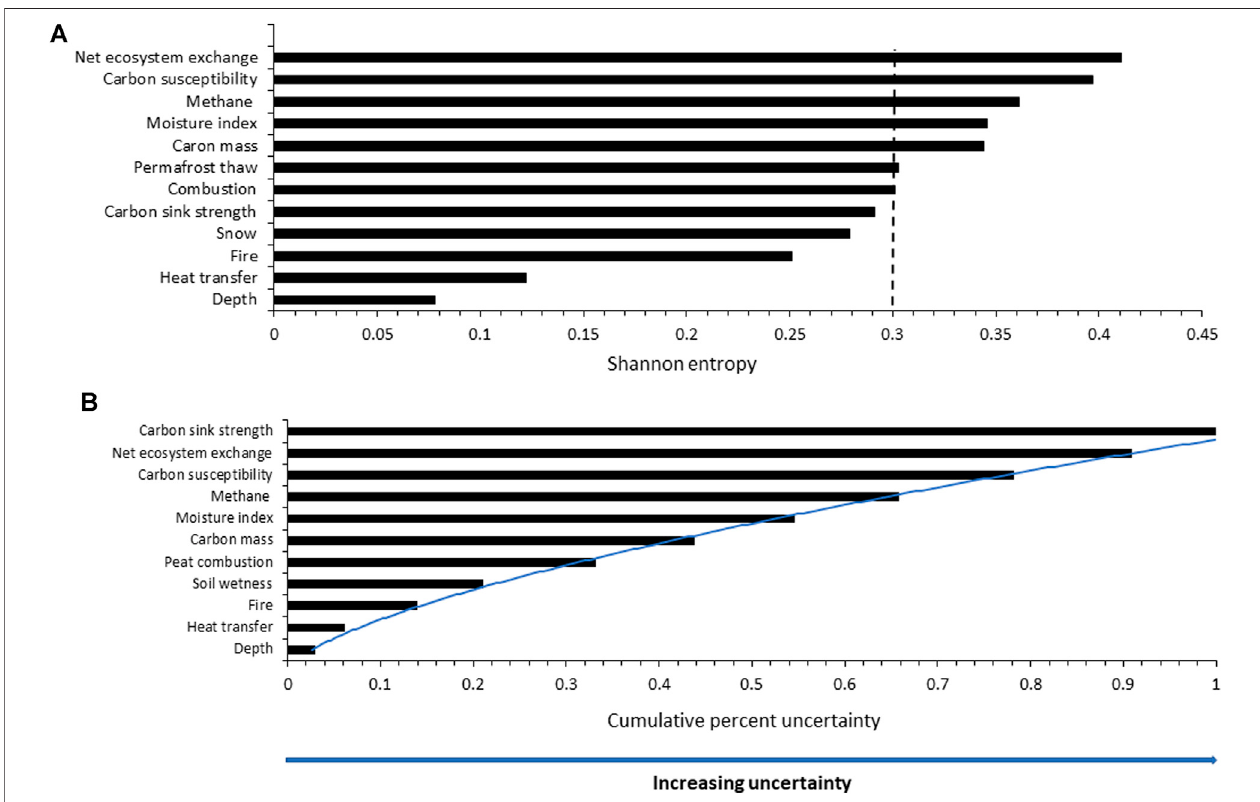
FIGURE 11 | Uncertainty of results for selected variables describing (A) posterior probability dispersion (Shannon entropy) and (B) cumulative probability in the standardized ( x i − x ) Shannon entropy in a 74,300 km 2 study area in the Hudson Bay Lowlands, Canada.